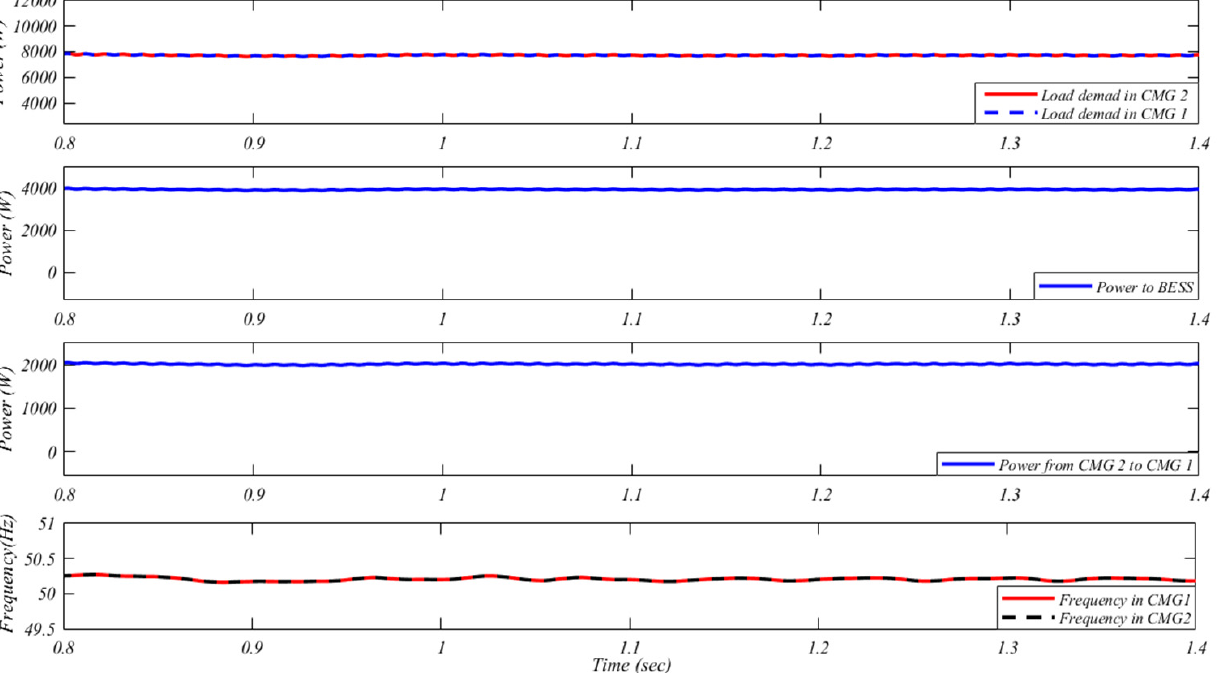
Figure 11. Experimental prototype of the proposed system. 5.1. Case 1: MGs Are Operated Independently and Sudden Load Change In this case study, both of the CMGs are operated separately and supplying the local load individually, as shown in Figure 12a. As a result, the implemented controller can maintain the desired voltage and frequency and provide the required load demand. Ini- tially, in the case of study 1 (Figure 12a), 10 A and 5 A current drawing load was connected